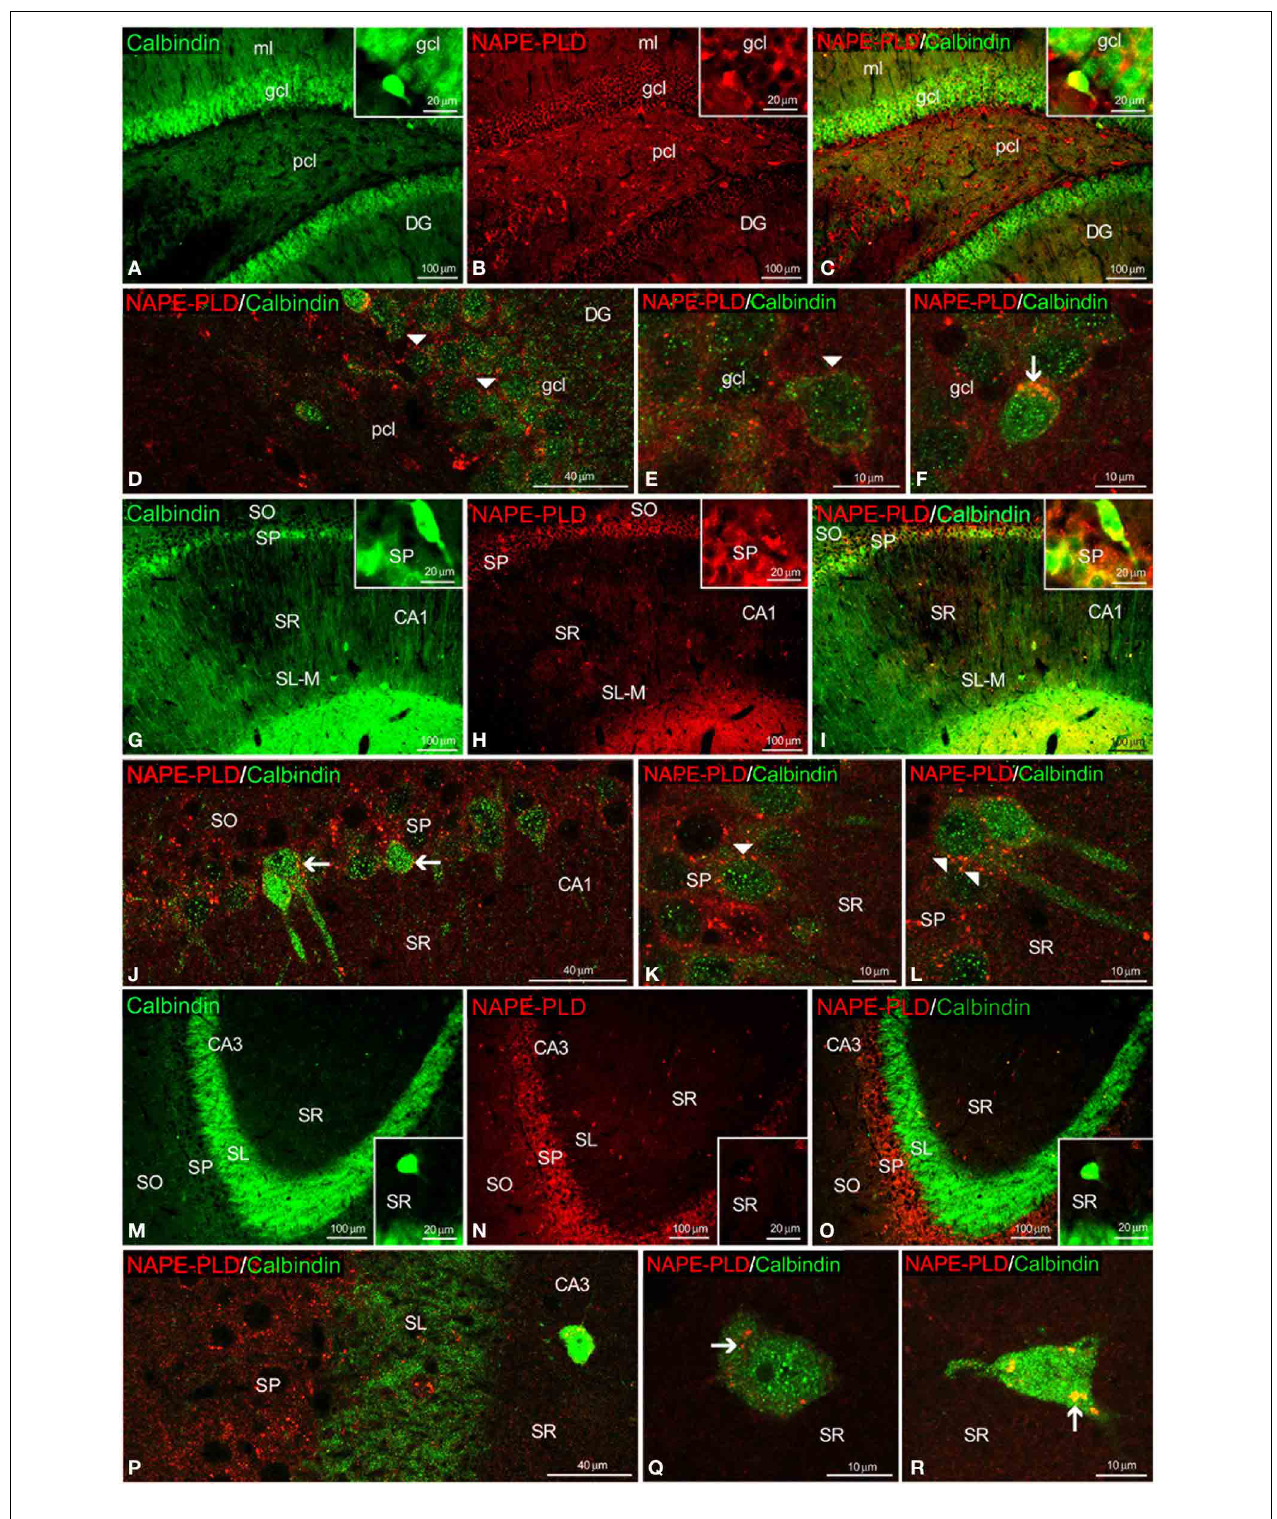
and CA3 areas. The arrows indicate NAPE-PLD expression in the calbindin + cells. The arrowheads indicate the NAPE-PLD + fiber varicosities on the surface of the calbindin + cells. For abbreviations, see Table 3 legend. Scale bars are indicated in each